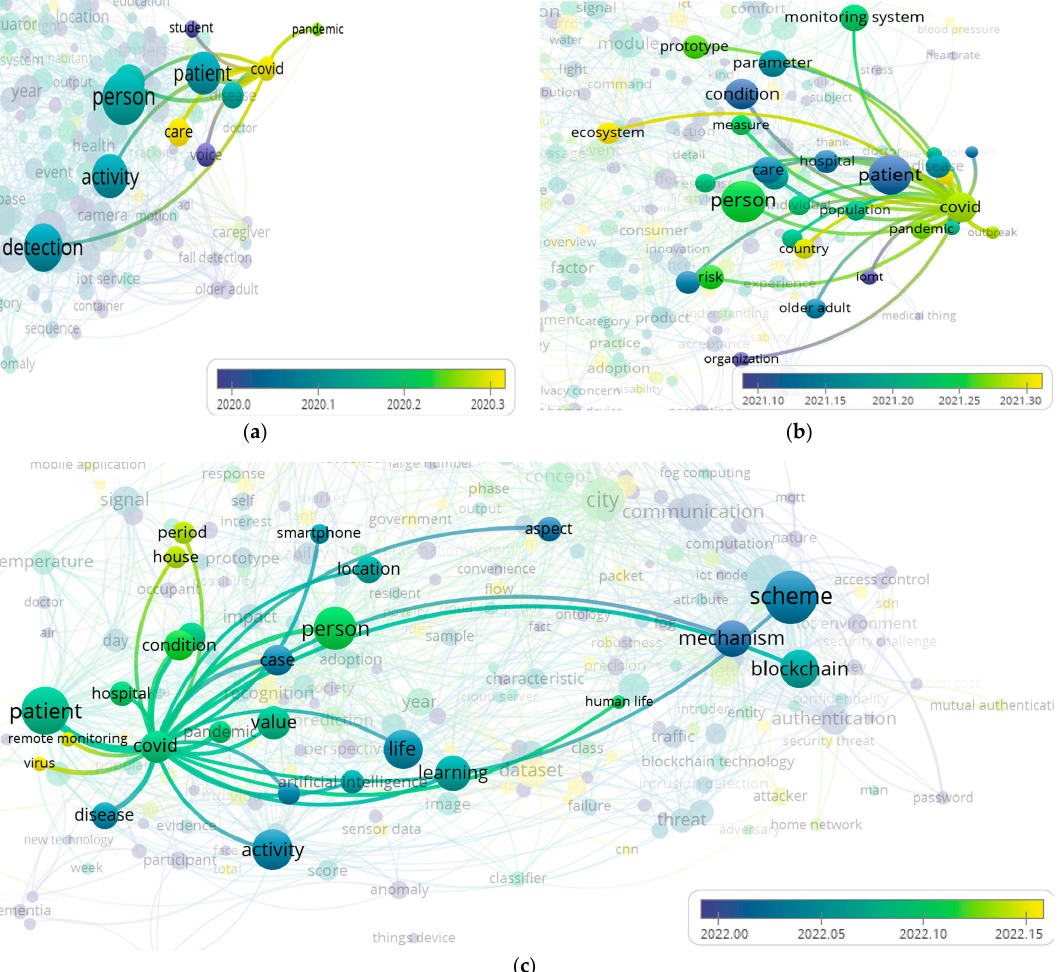
Figure 20. Topics related to COVID-19 in 2020–2022: ( a ) 2020, ( b ) 2021, and ( c ) 2022.